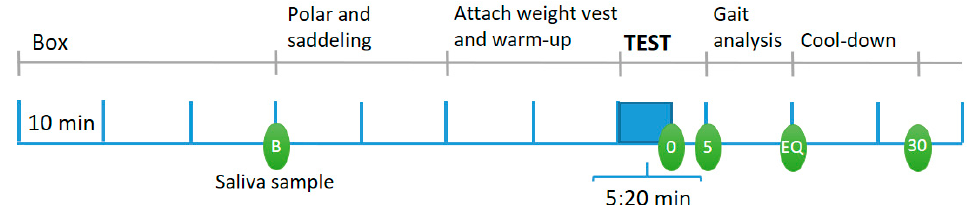
Figure 1. Daily procedure for the riding tests on Test Days 2–4. Five saliva samples were collected from each horse per day: B: Baseline; 0: Just after the dressage test; 5: 5 min after dressage test, EQ: Just after the saddle pressure / gait symmetry test, 30: 30 min after the dressage test.